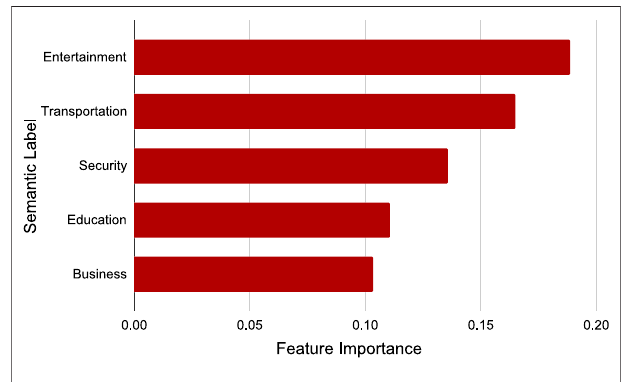
FIGURE 10 | Feature importance of spatial